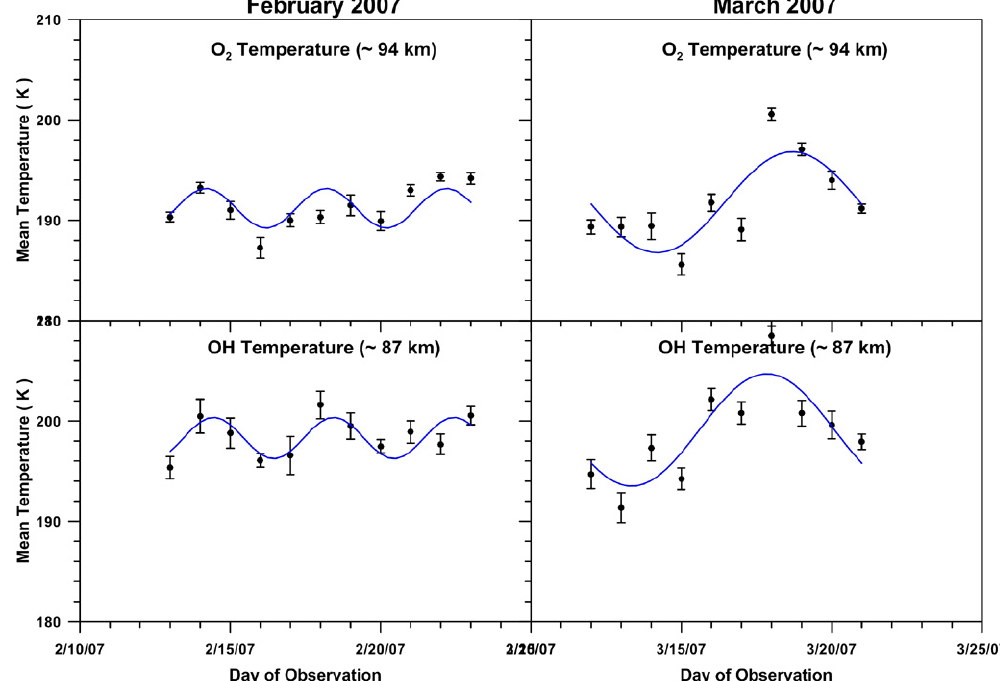
Fig. 7. Night-to-night variability of the averaged temperature between 22:00h and 01:00h at OH and O 2 altitudes during February and March 2007 along with the forced planetary wave fit based on Lomb–Scargle periodogram